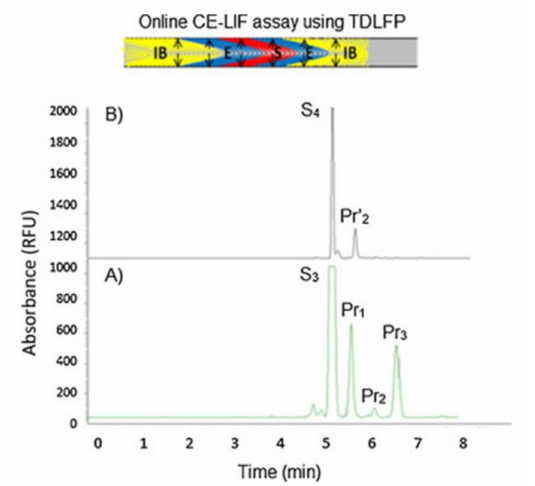
Figure 6. Electropherograms obtained by CE-LIF analysis for ( A ) S 3 or 5-FAM-Ala-Ala-Ala-Phe- Tyr-Asp-OH and ( B ) S 4 or 5-FAM-Arg-Glu-Ala-Val-Val-Tyr-OH hydrolysis by HNE. Reproduced with the permission of